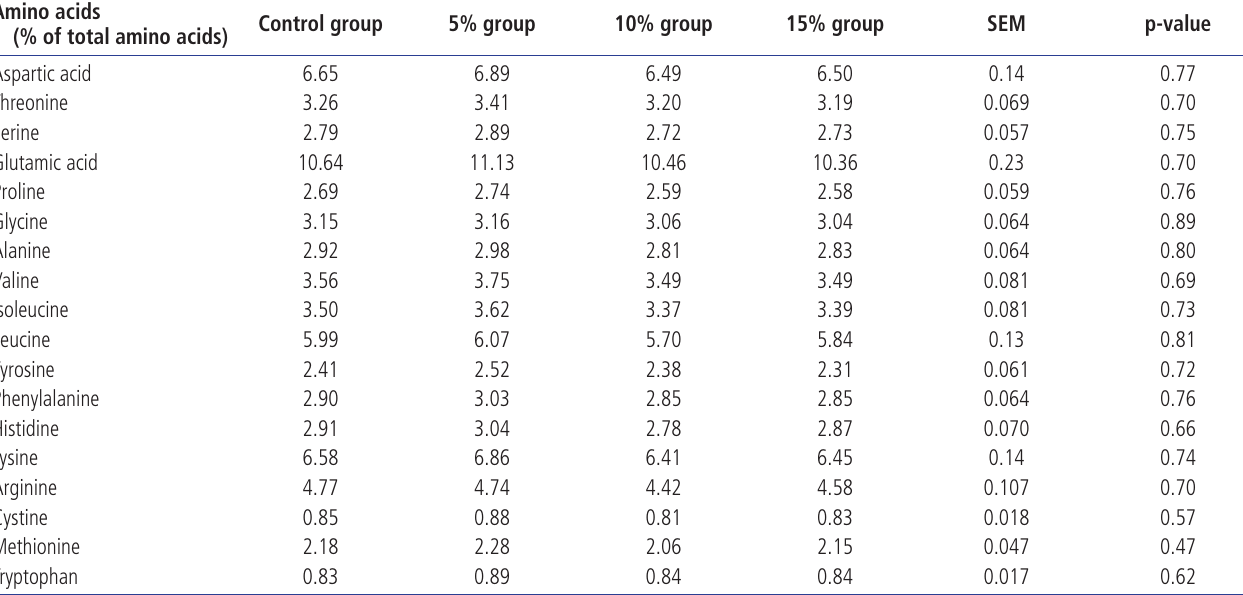
Table 6. Effect of Broussonetia papyrifera silage levels on amino acids composition of meat in black Angus Amino acids (% of total amino